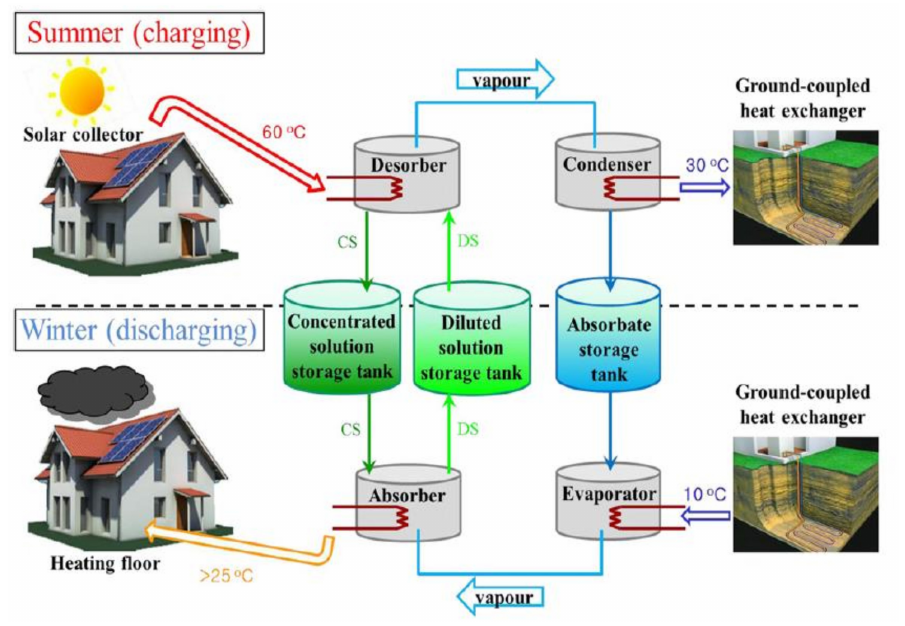
Figure 5. Liquid absorption TES systems